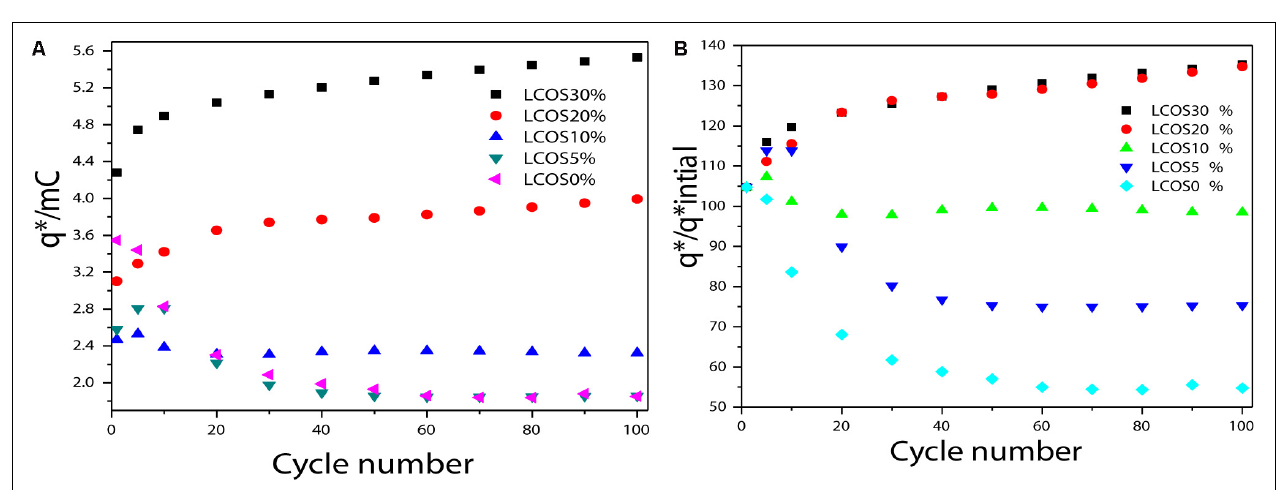
FIGURE 5 | (A) Charge ( q *) evolution and (B) q */ q * initial ratio of the LSCO0%, LSCO5%, LSCO10%, LSCO20%, and LSCO30% electrocatalysts during a stability test measurement.